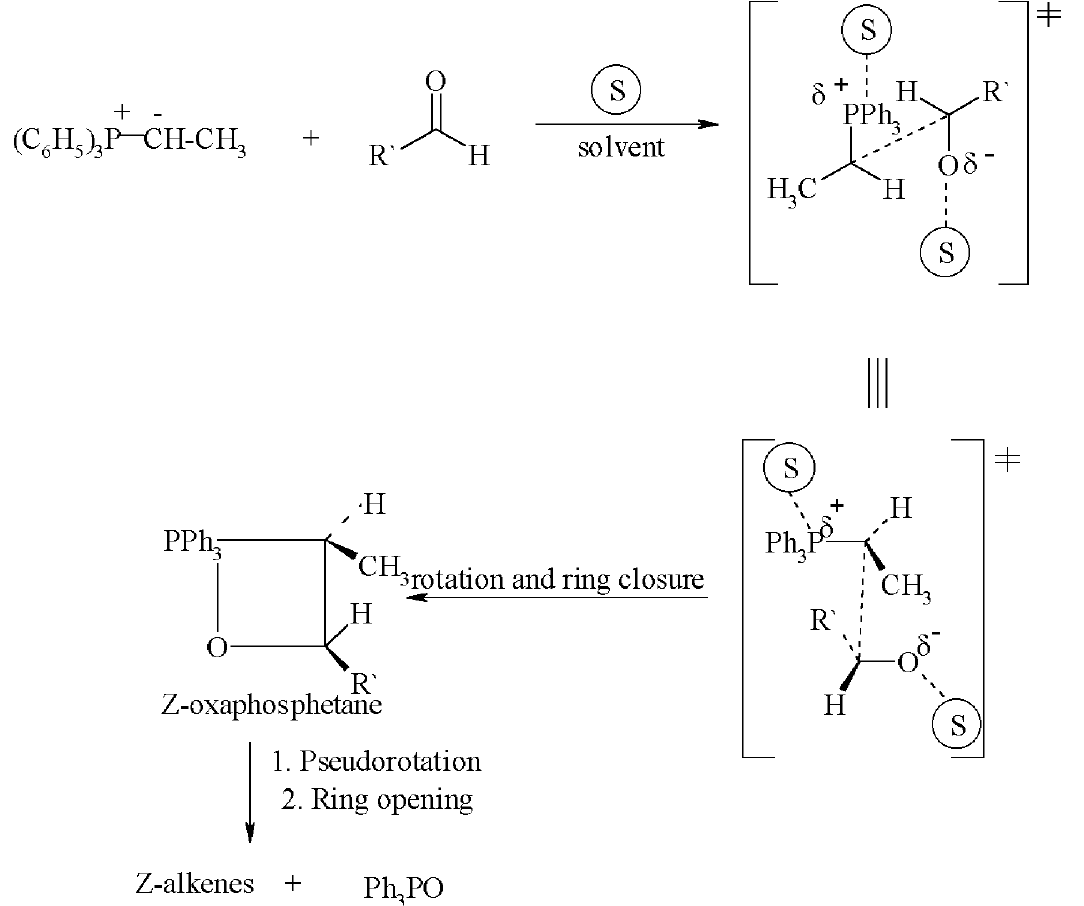
Scheme 5 The possible mechanism of Z -oxaphosphetane formation in